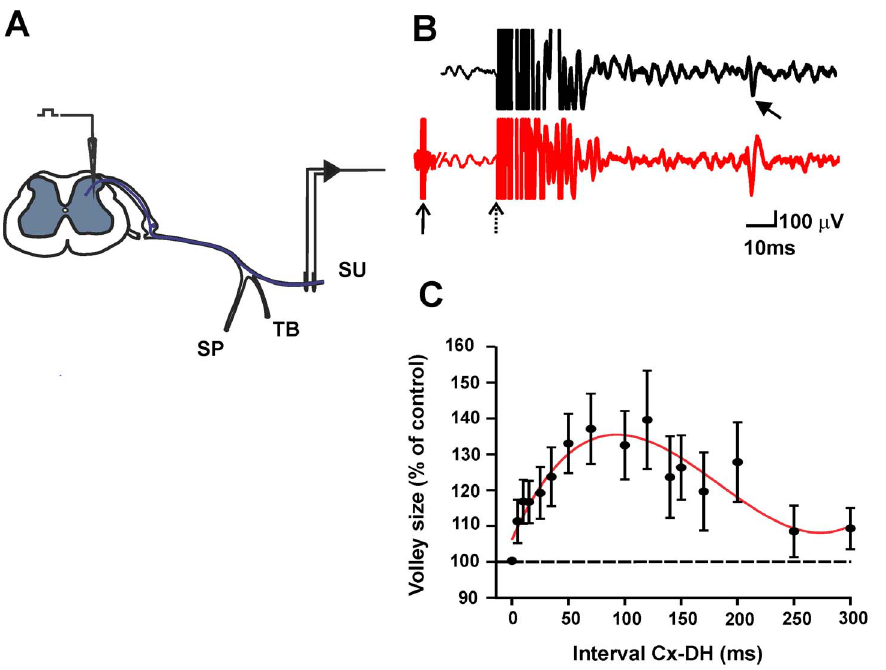
Figure 4. Time course of changes in excitability of slow conducting primary afferent terminals after stimulation of the contralateral sensorimotor cortex. A, experimental arrangement. B, antidromic slow conducting compound action potentials (bold arrow), recorded in the SU nerve, produced by superficial L4 dorsal horn stimulation alone (black) and when the this stimulation was preceded by sensorimotor cortex stimulation 70 ms earlier (red). Arrows indicates the dorsal horn (dotted arrow) and cortex (solid arrow) stimulation times. C, graph shows the amplitude of antidromic volleys at various intervals after the cortical stimulation. Amplitudes are expressed as percent of the amplitude of control antidromic action potentials. SU, Sural nerve; TB, Tibial nerve; SP, Peroneal nerve.